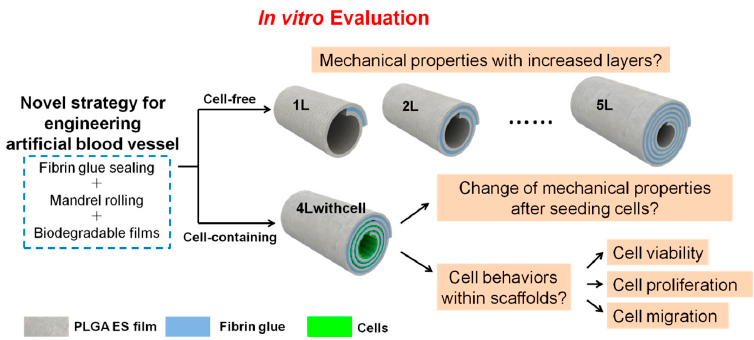
Figure 1. Schematic of in vitro evaluation of the novel artificial blood vessel. Cell-free and cell-containing scaffolds can be fabricated by this method. The substrate material is polylactic- co -glycolic acid (PLGA) electrospinning (ES) film. The model cell used is C2C12 mouse myoblast cell. The cell-free scaffolds containing 1.25, 2.25, 3.25, 4.25, and 5.25 layers are noted as 1L, 2L, 3L, 4L, and 5L, respectively. The 4L scaffolds containing cells in its innermost three layers are noted as 4Lwithcell. To fabricate the layered scaffolds without cells, the PLGA films were cut into rectangles with proper sizes, coated with two components of the fibrin glue on two sides of the film, and rolled around an ePTFE mandrel with proper outer diameters by hand. When rolling, the two components of the fibrin glue would react with each other and bond the layers. After the mandrel was gently extracted, the residual glue components in the scaffolds was washed with PBS and eventually only the reacted components that formed fibrin glue would be left in the scaffold. This process is illustrated in Supplementary Materials Figure S2. To fabricate the layered scaffolds with cells, cells were patterned by